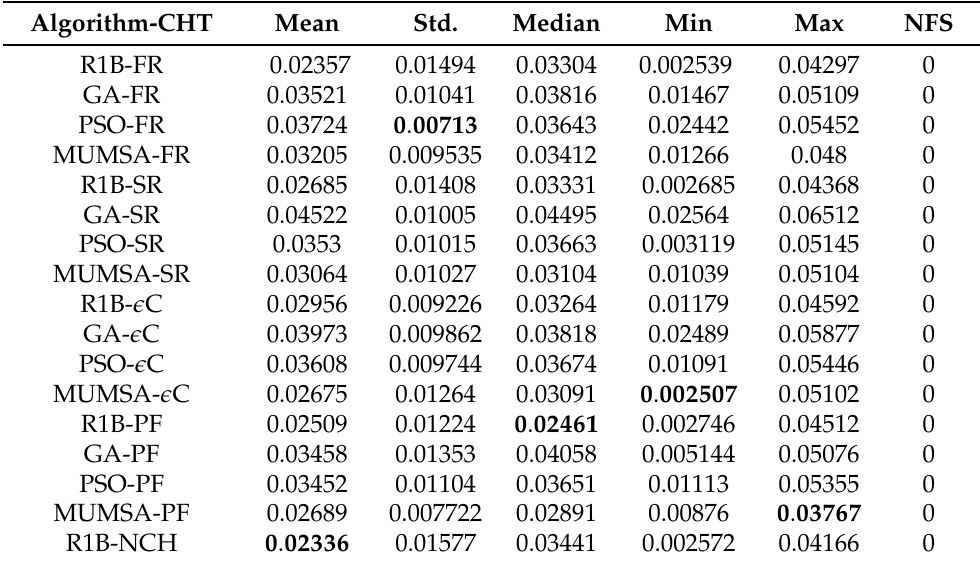
Table 6. Descriptive statistics of the obtained results for each metaheuristic algorithm in study case 1 with trajectory